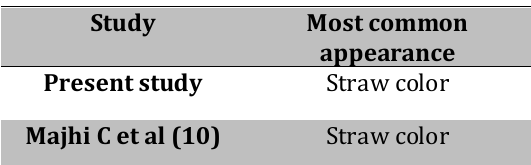
Table 6. Comparative study on colour of pleural